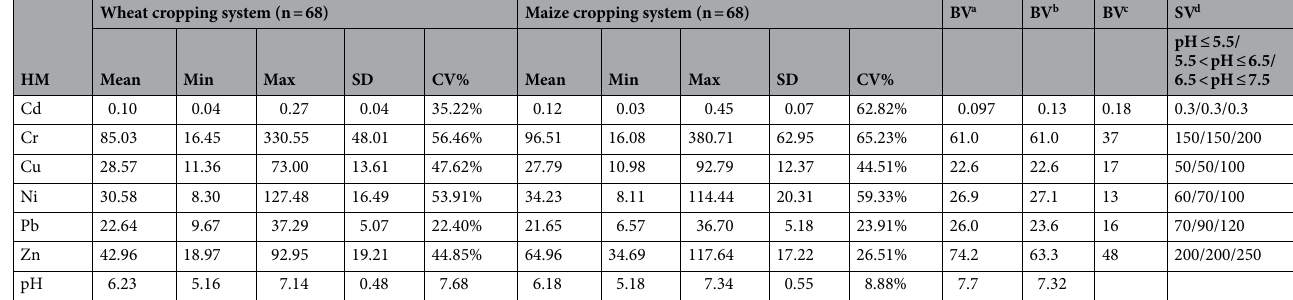
Table 1. Statistical characteristics of soil heavy metals in wheat–maize cropping systems (mg·kg - 1 ). HM = heavy metals; SD = standard deviation; CV = coefficient of variance; BV = background value; SV = standard value. a CNEMC (China National Environmental Monitoring Center) 1990. Soil Element Background Values in China. China Environmental Science Press, Beijing, China. b Background Values of Soil in Shandong Province 24 . c Background Values of Soil in United States of America 28,29 . d Environmental Protection Administration of China (EPAC;